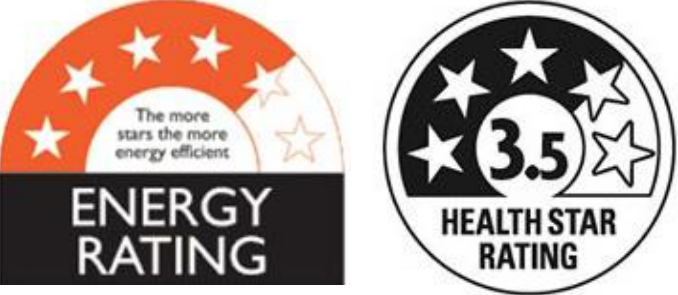
Figure 2. E3 (appliance energy use) and HSR (food nutritional value) product ratings labels.